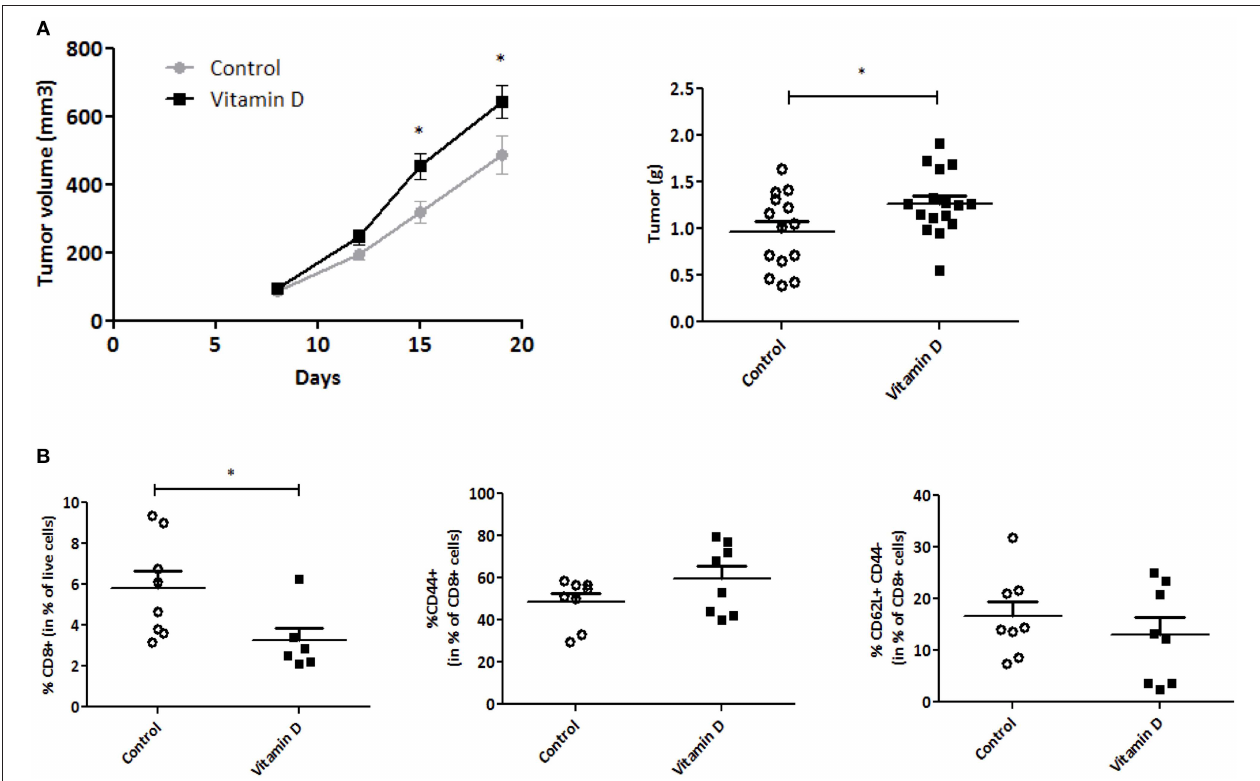
FIGURE 5 | Vitamin D increases EO771 tumor progression in overweight mice. EO771 cells were injected in the fat pad of the mammary glands ( n = 8) of female mice fed with high-fat diet. (A) The tumor size was measured with a caliper. The values of tumor volume (mm 3 ) are reported (Mean ± SEM). (B) Tumors were weighed at the end of the experiment (g). (C) CD8 + T cells and their markers were quantified by flow cytometry. Statistical significance between control and VD groups was determined by two-tailed Student’s t -test. * P <